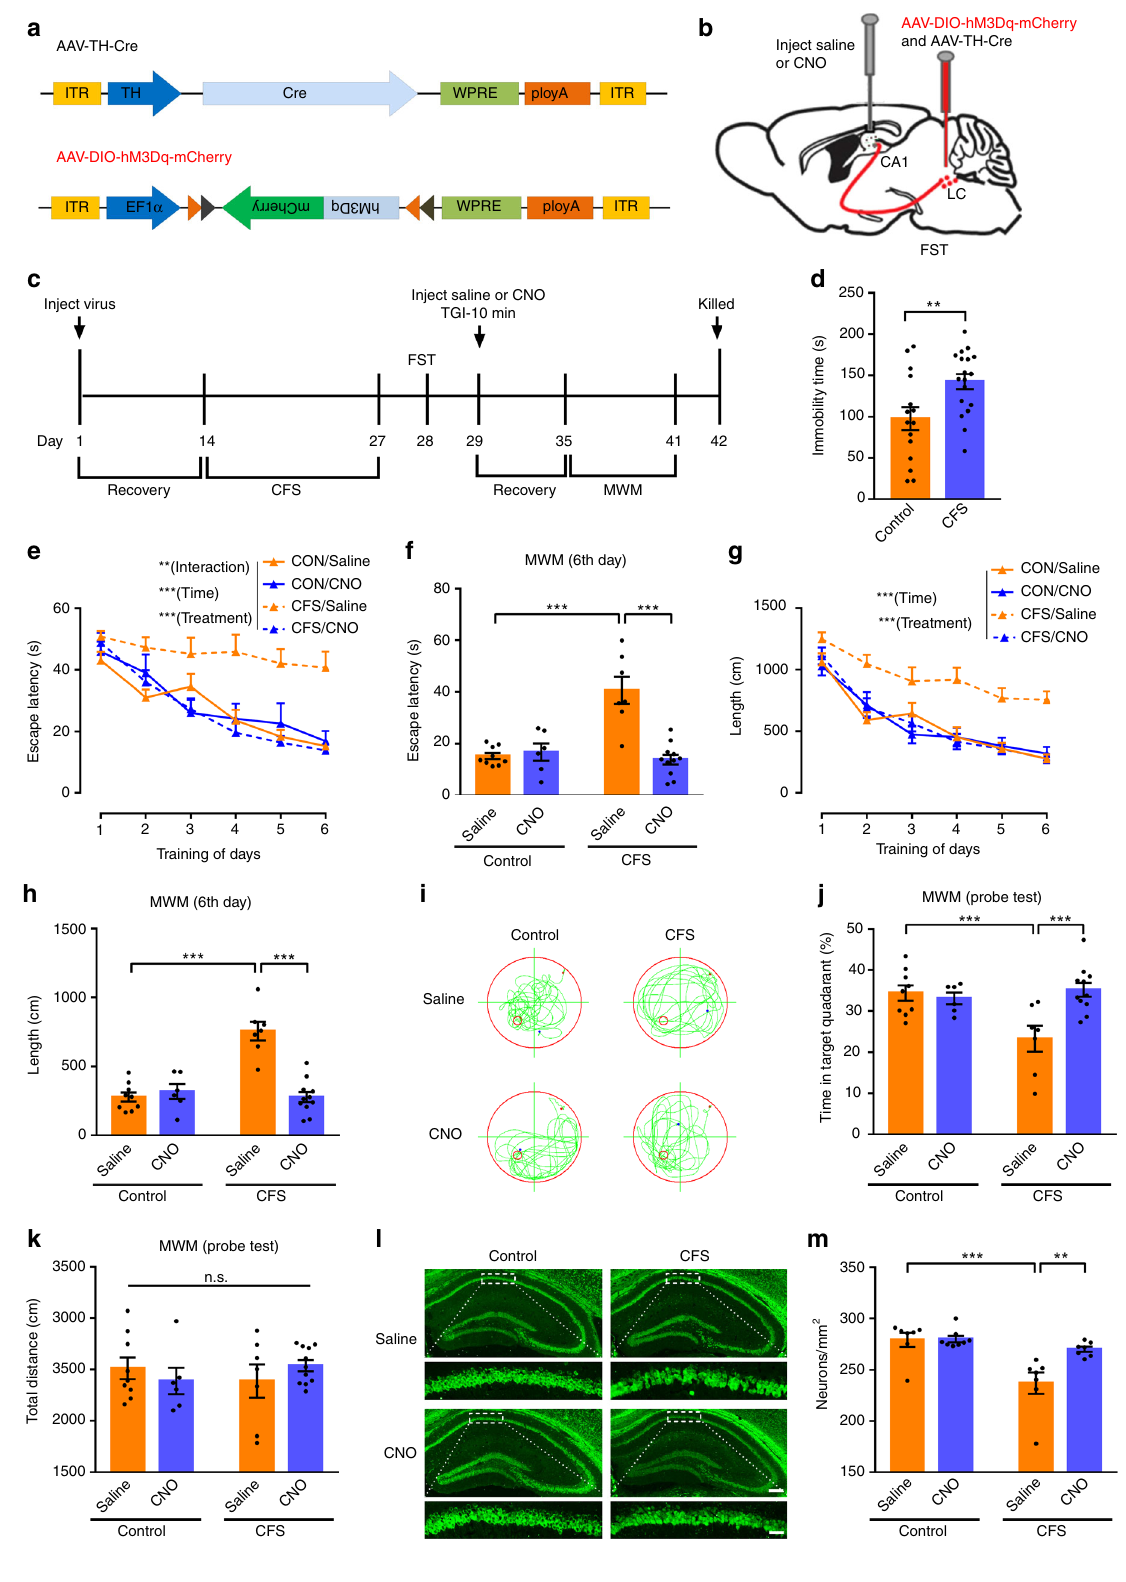
Forced swimming test . Mice were placed in 20 cm of water (24 ± 2°C) in Plexiglas experimenter. The total training took 6 days and then followed by the probe test on cylinders (30 cm height × 15 cm diameter) for 6 min The behaviour of mice was the seventh day. For probe trials, the platform was removed, and each mouse recorded by a video-tracking system (Shanghai Xinruan Information Technology was allowed to swim for 120s. The escape latency, distance travelled, time in Co. Ltd., China) and the immobility time was recorded automatically during the target quadrant and the total distance were recorded automatically for following session of 6 min. Mice were considered immobile when it remained fl oating in the analysis. NATURE COMMUNICATIONS| (2019) 10:2942